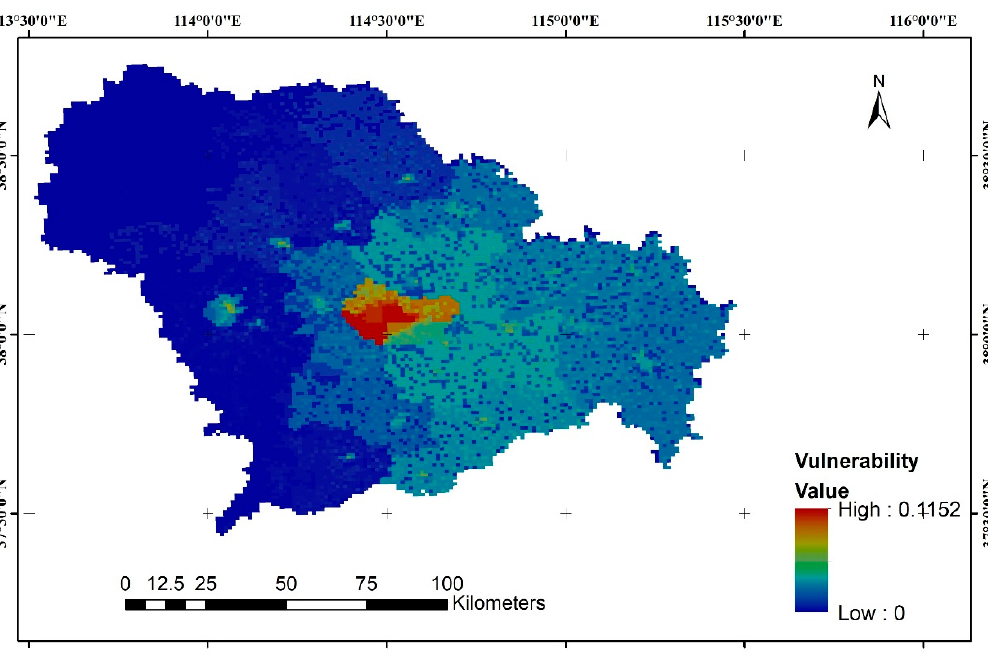
Figure 6. Flood vulnerability factor map of Shijiazhuang.